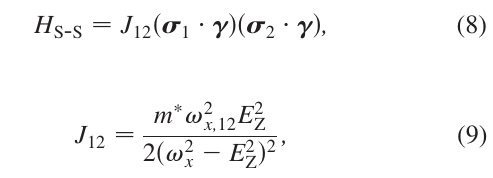
FIG. 2. The dependence (a) of the induced charge, q and (b) of the derivative of the induced charge, at r ¼ 0 , ð @q =@x Þ j , on a , which is the in-plane distance from the r ¼ 0 ind 0 center of the cylindrical gate to the center of the QD. We plot these two quantities for several vertical distances d between the QD and the gate: d=R ¼ 0 : 1 , 0.5, 1, corresponding to the solid, dashed, and dotted lines,